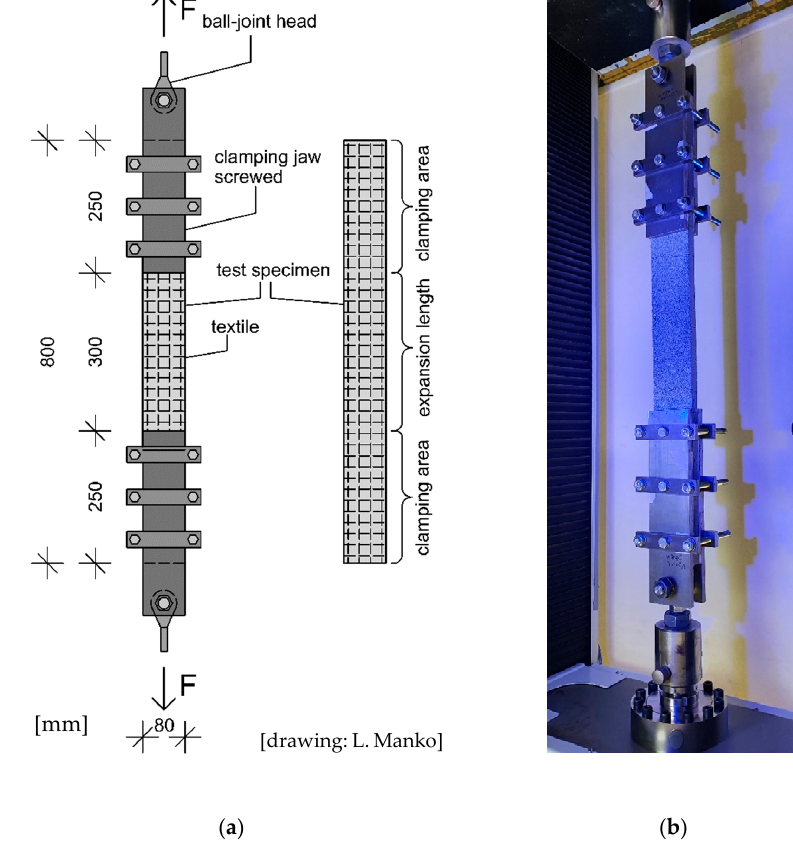
Figure 9. Test setup for the tensile tests on the composite material. ( a ) Schematic representation; ( b ) laboratory setup. Table 3. Characteristics of the composite materials; mean values of four single tests each ± standard